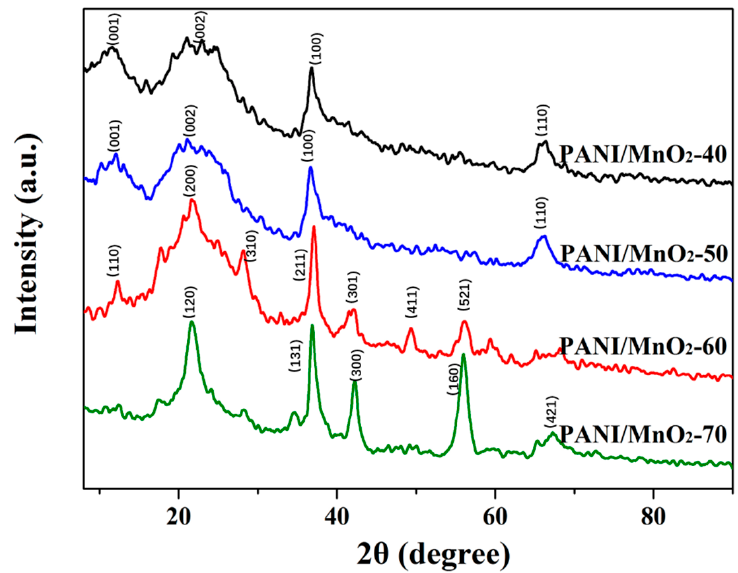
Figure 6. XRD patterns of PANI/MnO 2 composites.